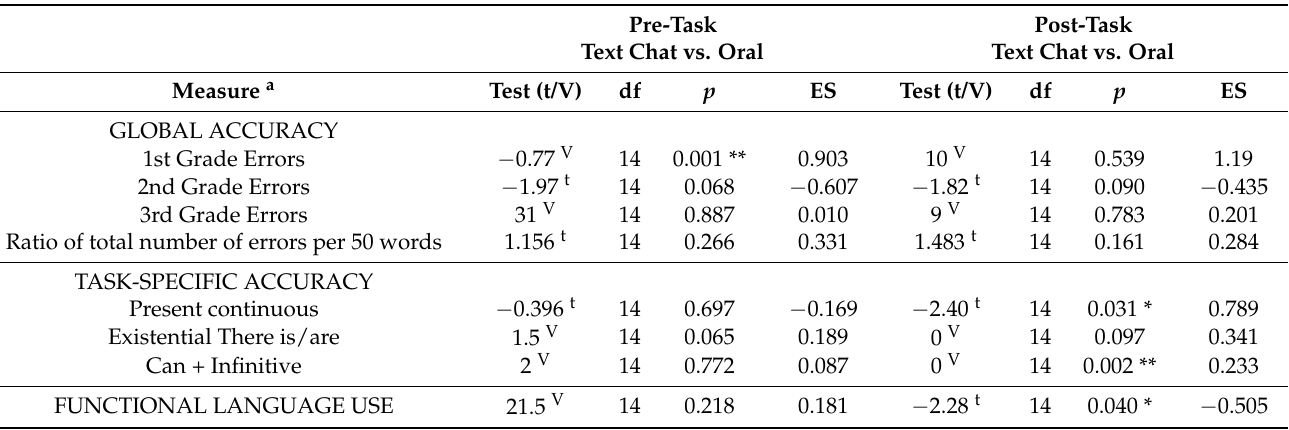
Table 4. Inferential statistics comparing text chat vs. oral performances on pre- and post-tasks ( N = 15).